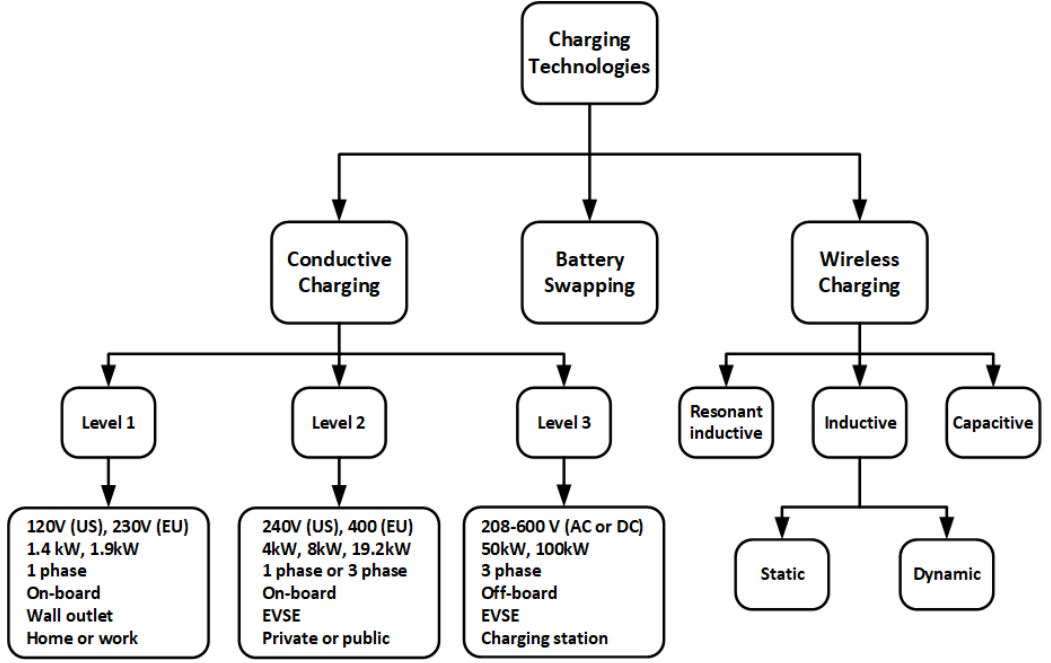
Figure 2. Classification of EVs charging technologies.